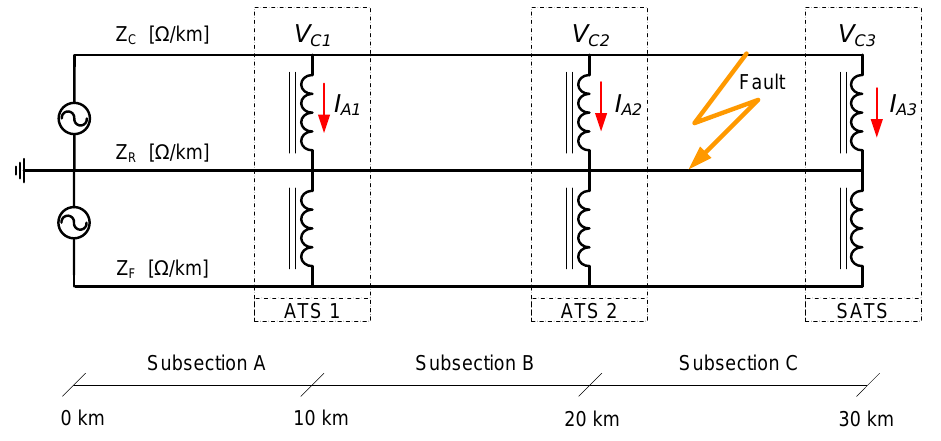
Figure 3. Simulated 2 × 25 kV power supply system with two conductors and return grounded wire. Fault in subsection C between catenary and rail.